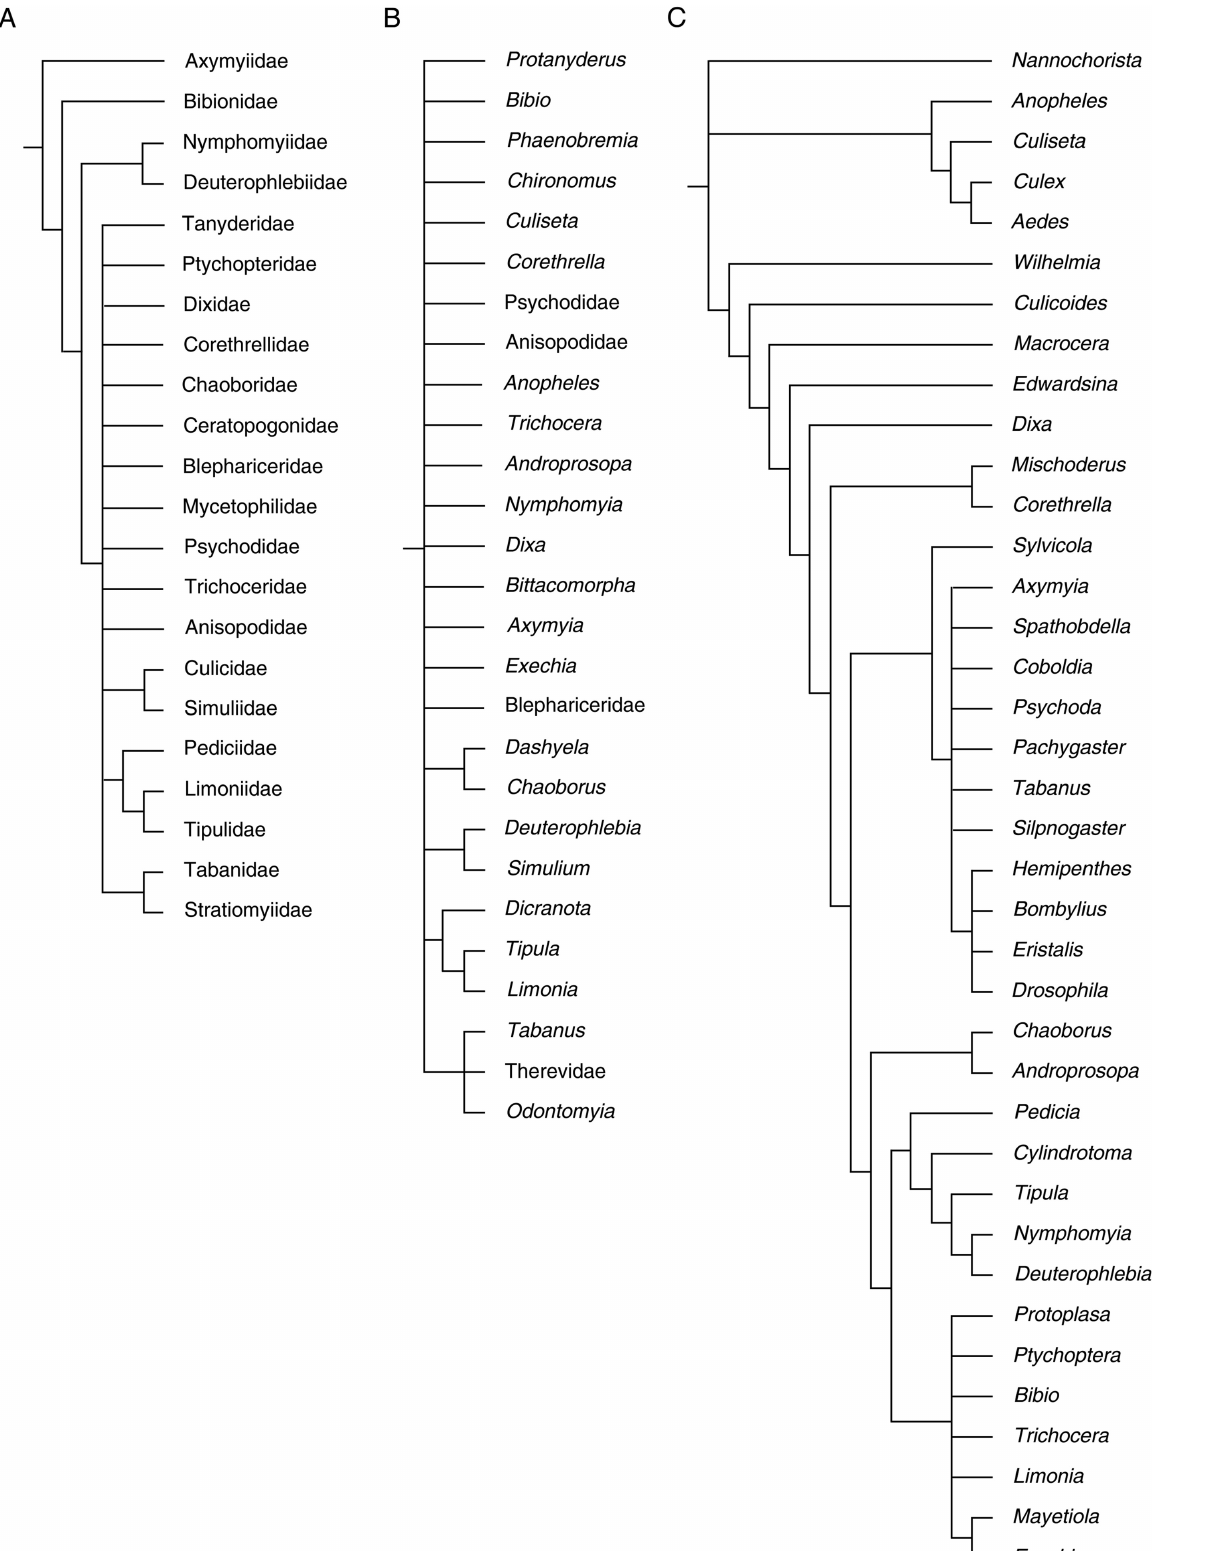
Figure 1 . Strict consensus trees based on: A, the complete data set (CI 0.33, RI 0.29). B, larval head structures (CI 0.26, RI 0.21). C, adult head structures (CI 0.25, RI